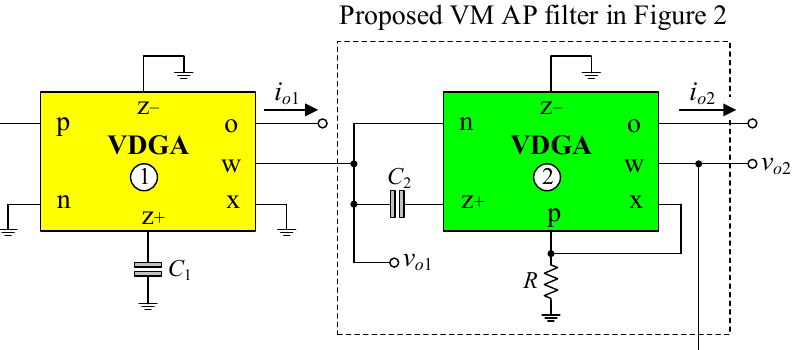
Figure 21. Dual-mode quadrature oscillator implemented from the proposed VM AP filter circuit.